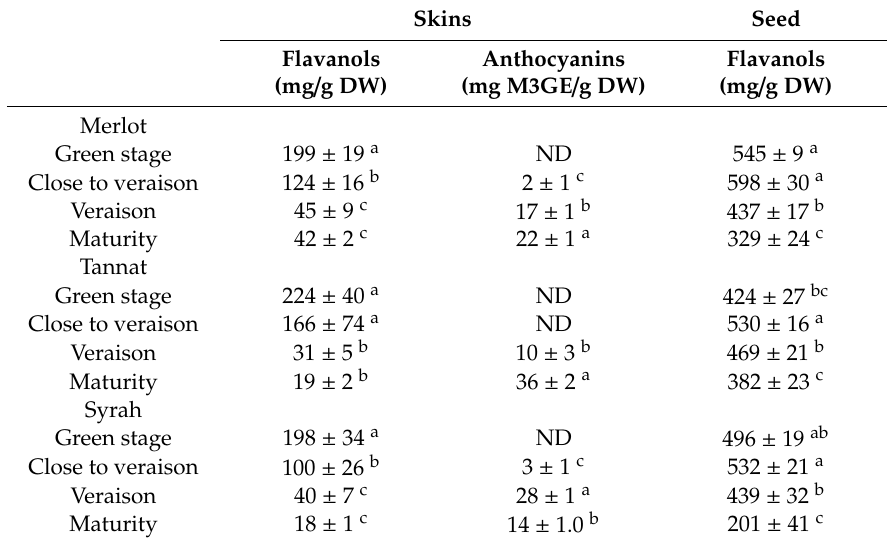
Table 1. Phenolic composition of skin and seed grape extracts of the studied varieties at di ff erent stages of ripening.